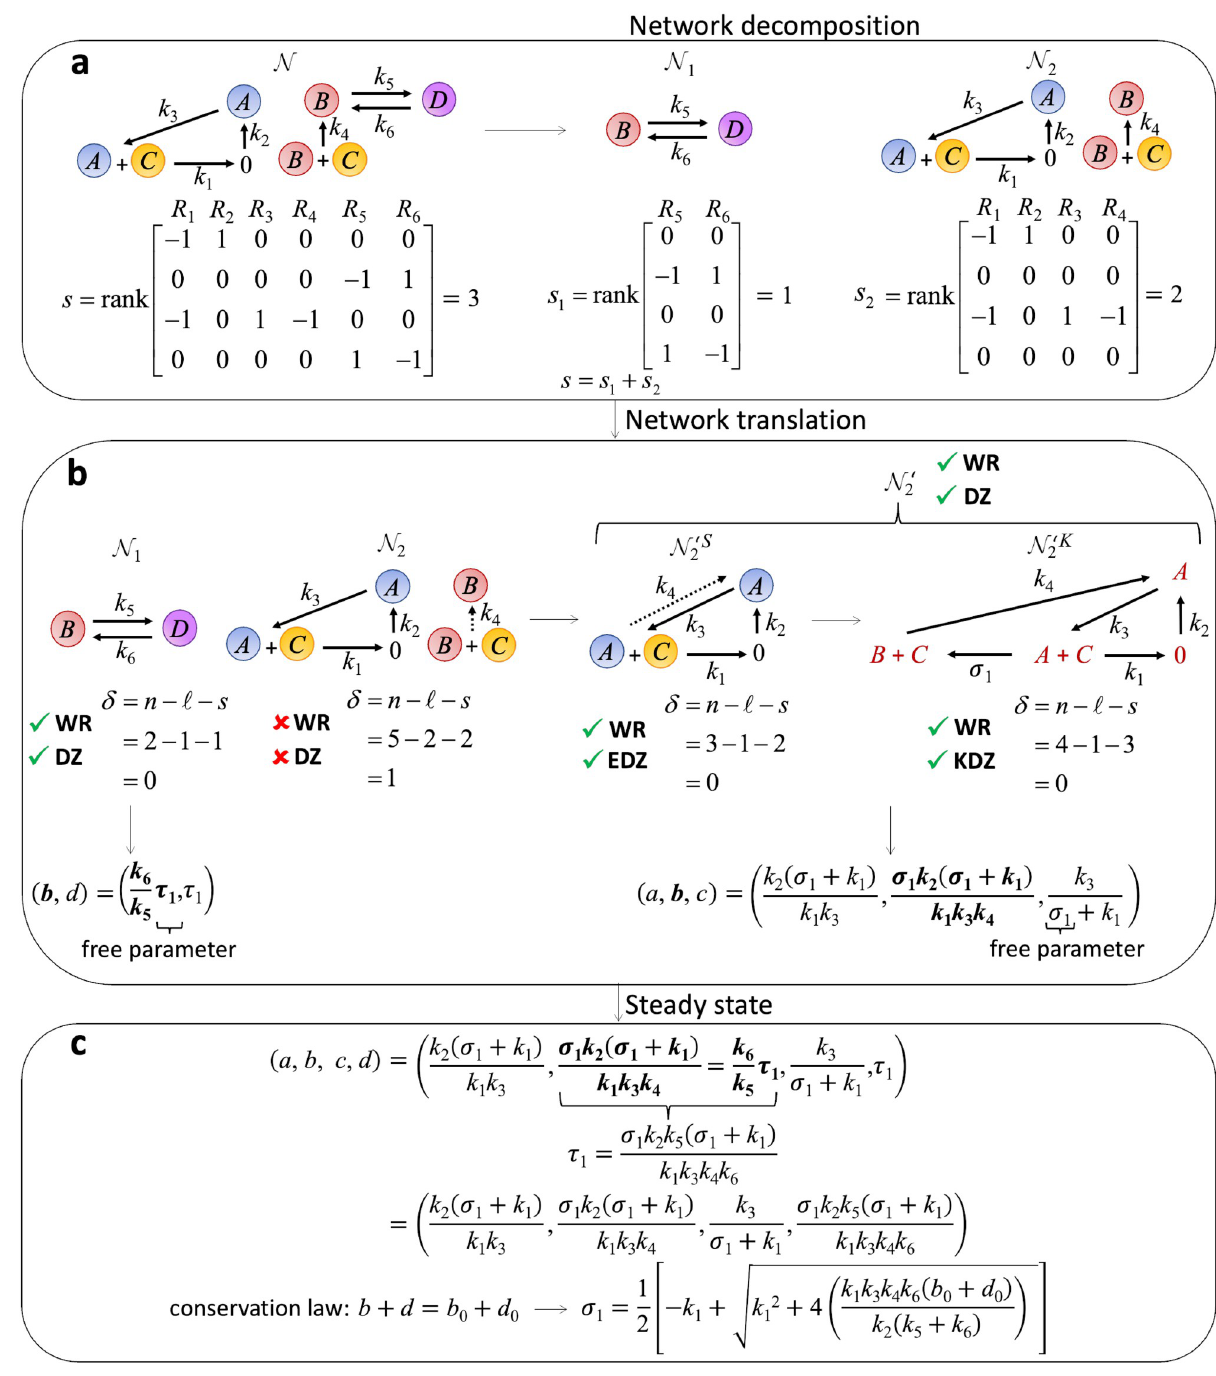
Fig 1. Derivation of analytic steady state via network decomposition. a The CRN ( N ) is decomposed into independent subnetworks ( N and N ) in 1 2 such a way that the rank of the original matrix ( s ) is equal to the sum of the ranks of the stoichiometric matrices of subnetworks ( s 1 + s 2 ). b Since the subnetwork N is not WR and DZ, network translation is performed. The translated subnetwork ( N 0 ) is WR and DZ, i.e., its stoichiometric and 2 2 and N 0 K , respectively) are both WR and DZ, while its dynamics is equivalent to the dynamics of the original subnetwork ( N ). kinetic-order CRNs ( N 0 S 2 2 2 Then, the steady states of the original subnetwork ( N ) and the translated subnetwork ( N 0 ) can be analytically derived since they are WR and DZ (see 1 2 Fig 2 for details). c The steady states of subnetworks are merged to identify the steady states of the original networks. In particular, the steady states of and N (i.e., species B ) are equated, which eliminates the free parameter τ 1 . Then, by combining the steady state of every the common species of N 1 2 species, the steady state of the original network can be derived with one remaining free parameter σ 1 . This σ 1 is computed from the conserved quantity in the network, which is the sum of the initial concentrations of species B and D (i.e., b 0 + d 0 ). https://doi.org/10.1371/journal.pcbi.1011039.g001 PLOS Computational Biology | https://doi.org/10.1371/journal.pcbi.1011039 April 13,